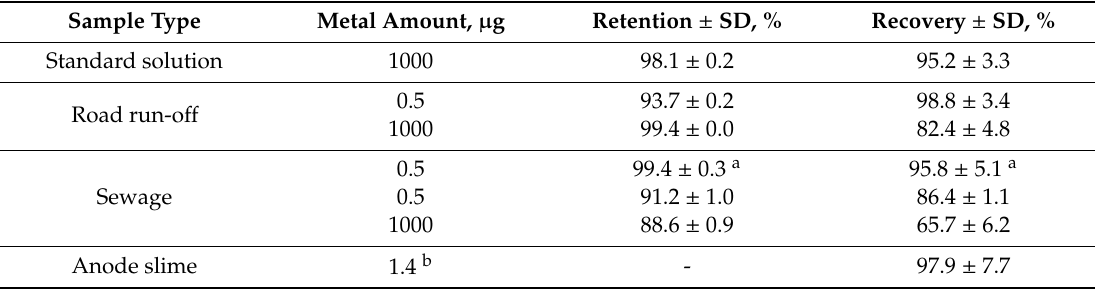
Table 4. Application of fungi Aspergillus sp. for separation of Pd(II) from various samples